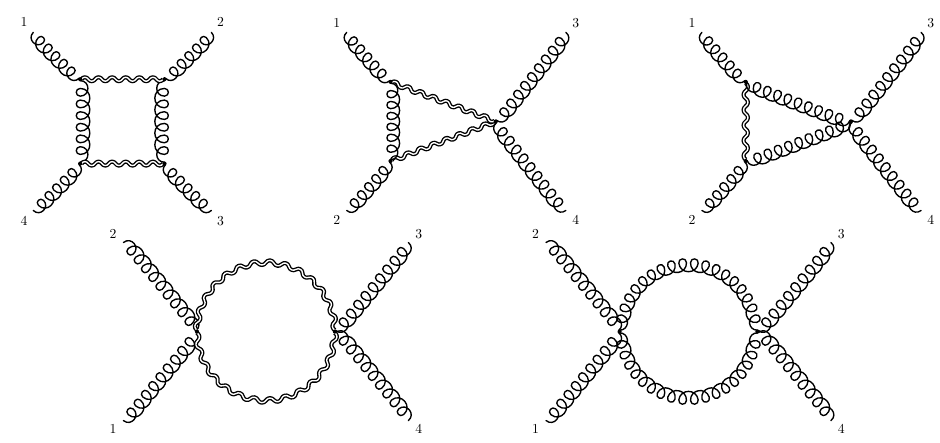
Figure 13 . The expression (5.9) for the κ 4 order of the four-gluon EYM amplitude at one loop mixes box integrals with triangles and